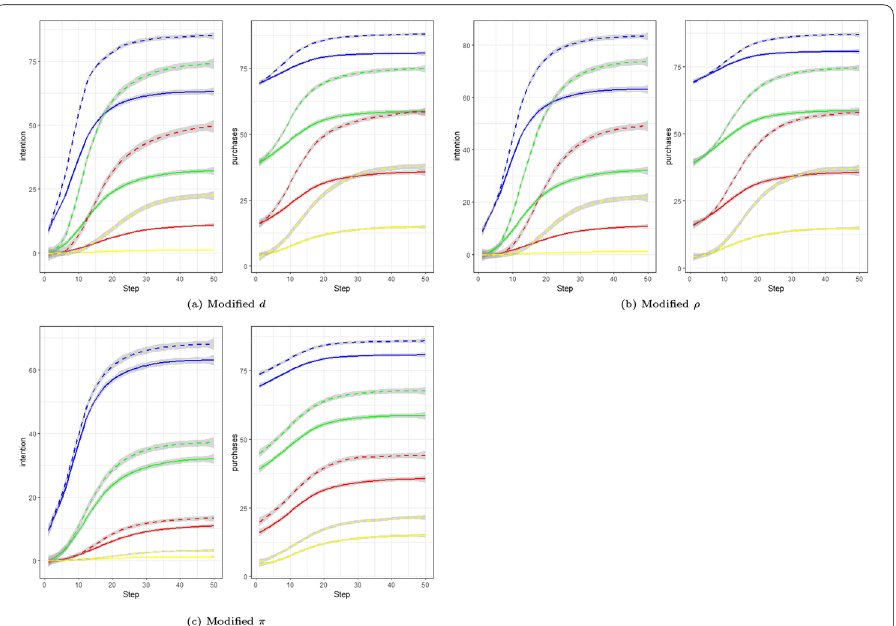
Fig. 4 Evolution of intention and purchase, for baseline and modified parameters ( n d = 4 ). Continuous lines represent baseline setup, dashed ones represent parameters modified individually. The impact of network‑related parameters appears as higher for combined dimensions. Curves’ legend: 1D , 2D , 3D , 4D . The grey shade represents the confidence interval for each curve at 95%